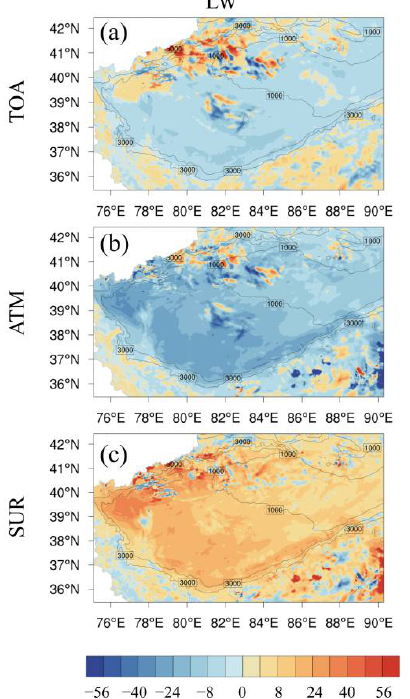
Figure 10. Spatial distributions of the mean LW DDRE in W m −2 over the TB ( a ) at the top of the atmosphere (TOA), ( b ) at the surface (SUR), and ( c ) in the atmosphere (ATM) on 29 April 2015, at 18:00 UTC.